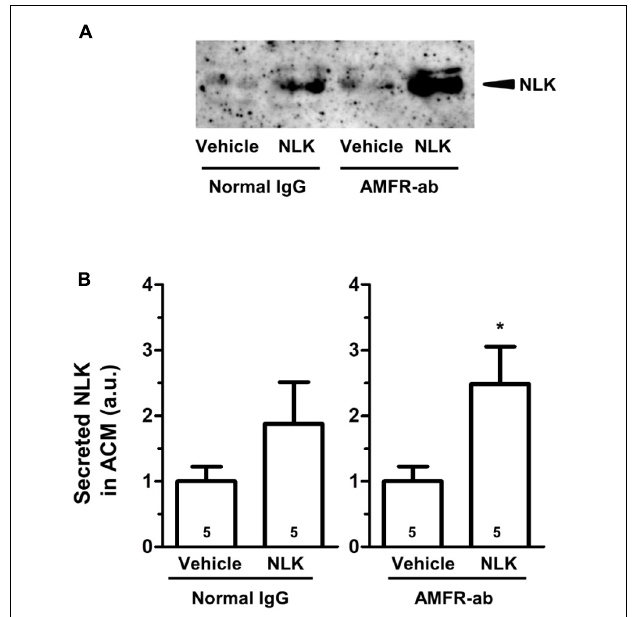
FIGURE 3 | Autocrine motility factor receptor (AMFR) was not likely to be involved in the neuroleukin (NLK)-induced NLK secretion signal in cultured astrocytes. Spinal cord astrocytes were cultured for 4 days and then treated with AMFR neutralising antibody (AMFR-ab, 1 µ g/ml) or normal IgG (1 µ g/ml) for 15 min. Thereafter, NLK (500 ng/ml) was administered to the cells. At 5 days in vitro , the medium was replaced with serum-free medium, the cells were cultured for 24 h, and then the astrocyte conditioned medium (ACM) was collected. (A) NLK in ACM was detected by western blotting. (B) The band intensity of NLK in the ACM was quantified. ∗ p < 0.05 vs. vehicle, unpaired two-tailed t -test. Numbers in the graph bars indicate the number